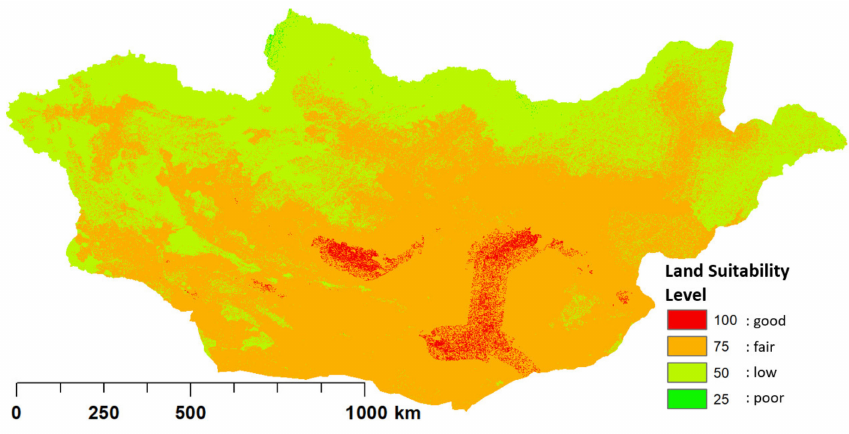
Figure 11. Suitability map for installing PV systems in